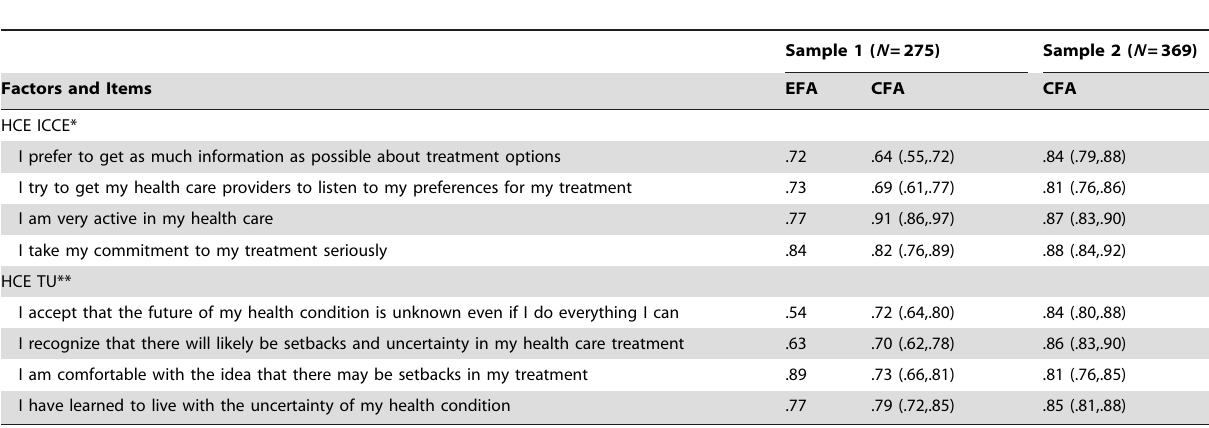
Table 2. Factor loadings and 95% Confidence Intervals for Samples 1 and